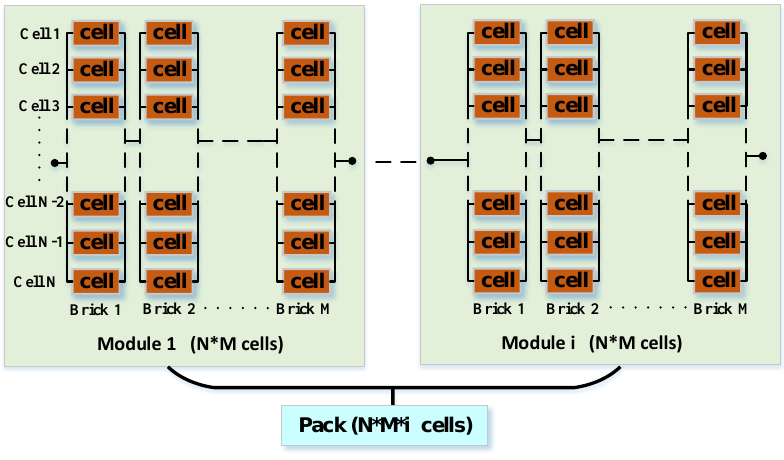
Figure 7. The structure of the battery system of the Tesla Model S.